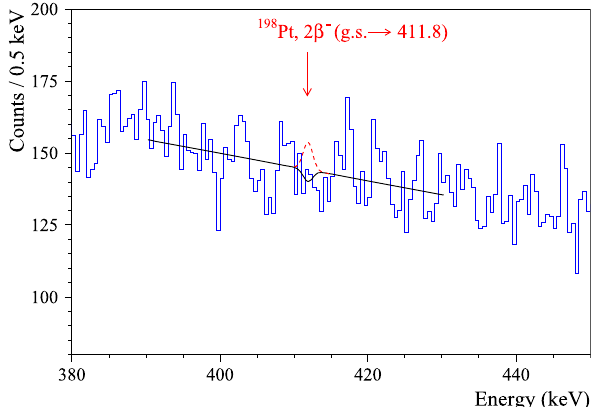
Fig. 11 PartoftheenergyspectrummeasuredwiththePtsamplewhere a peak with energy 411.8 keV after the 2 β − decay of 198 Pt to the first 2 + 411.8 keV excited level of 198 Hg is expected. The fit of the data is presented by solid line, the excluded γ peak is shown by dashed